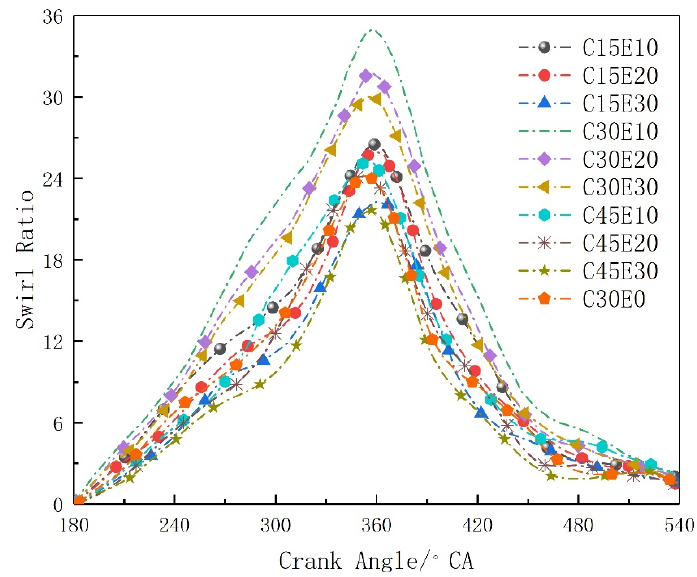
Figure 5. Influence of the inclination angle α and divergence angle γ on the swirl ratio. Note: the rotation speed was 2000 r/min; the scheme numbers are the same as those in Table 1.